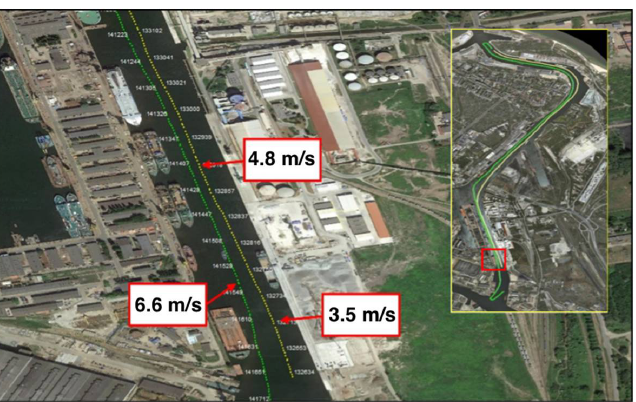
Figure 6. View of the passage during dynamic tests with individual measurement positions.